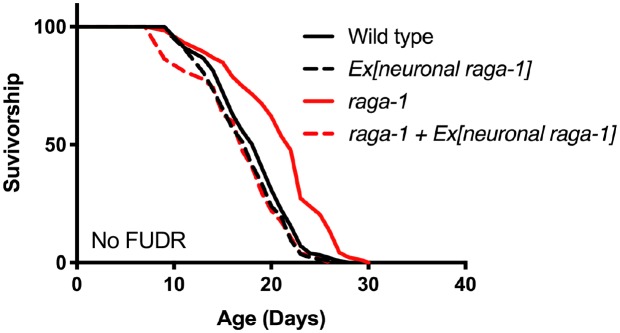
Neuronal raga-1 expressed by extrachromosomal transgene suppresses raga-1 mutant longevity when animals are not treated with FUDR to prevent progeny development.Details on strains and lifespan replicates can be found in Supplementary file 6.